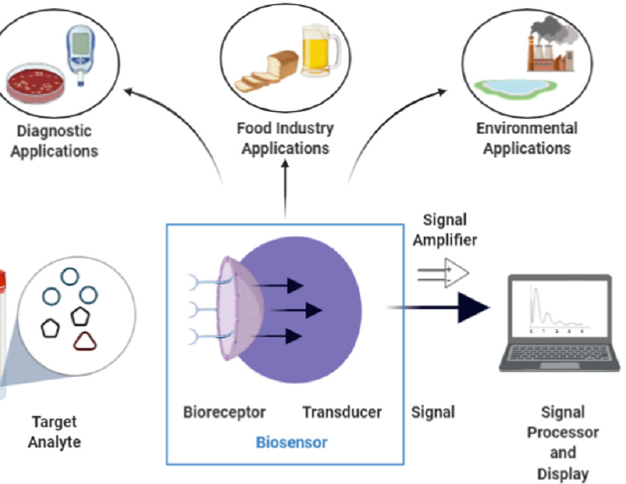
Figure 1. Use of standard biosensors with transducer and signal amplification for data processing.